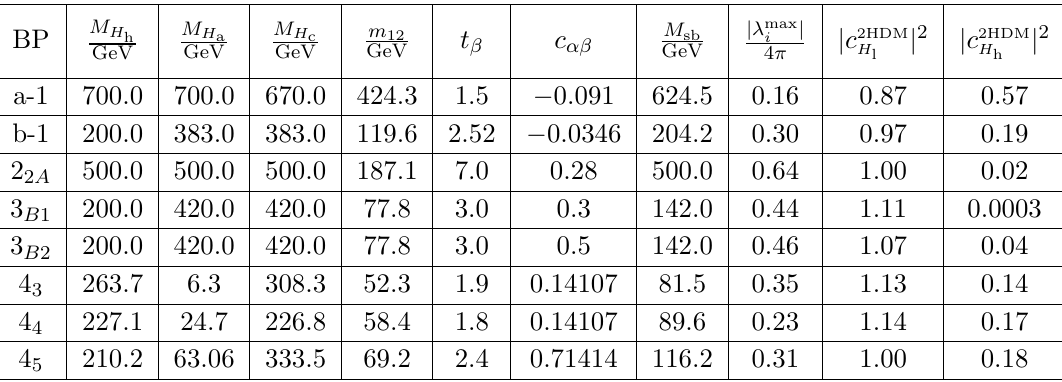
Table 2 . 2HDM benchmark points (BP) outside the alignment limit taken from ref. [68] (a-1, b-1) and ref.